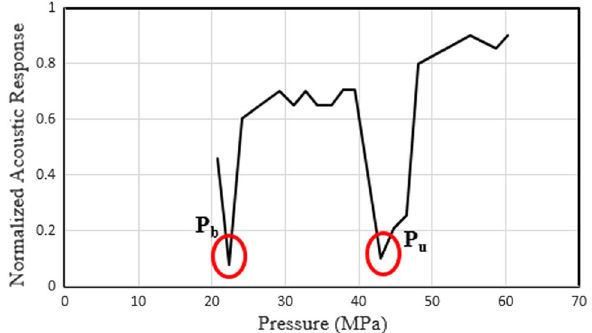
Fig. 25 Determination of AOP pressure for a live oil sample at 210 °F using ART (Jamaluddin et al.